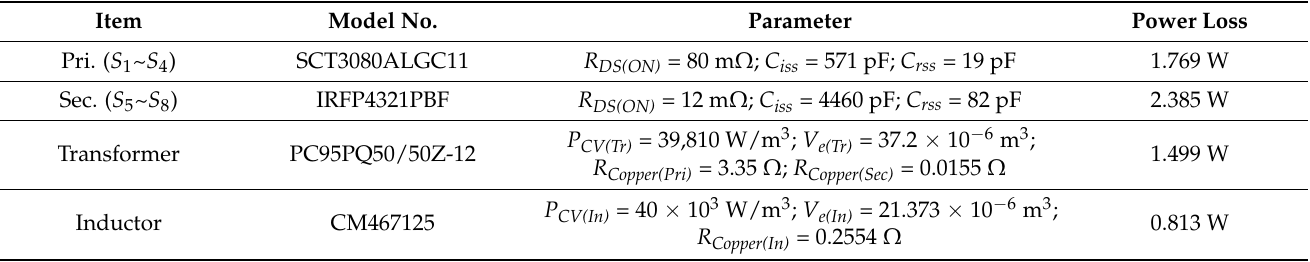
Table 5. Power loss calculations for the prototype converter at 100 W.